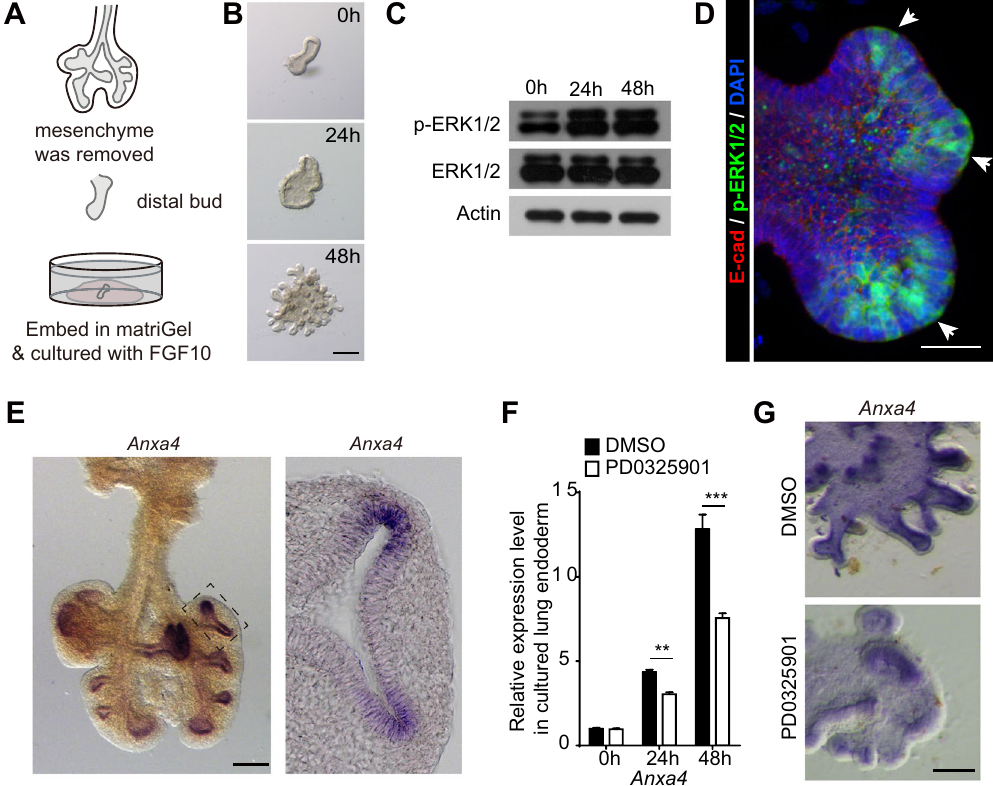
Figure 2. ERK1/2 signaling regulates the expression of Anxa4 . ( A ) Diagram illustrating the method for mesenchyme-free lung endoderm culture. Whole lung at E11.5 was digested with trypsin on ice and then the mesenchyme was removed using fine forceps to get intact lung endoderm. The distal lung endoderm buds were dissected out, embedded in Matrigel and cultured in serum-free medium containing recombinant FGF10. ( B ) Images of cultured lung endoderm taken at different time points. There is no obvious bud formation at 24 h after culture. By 48 h, the lung endoderm starts budding and forms many buds. Scale bar: 200 μ m. ( C ) Western blot of cultured lung endoderm explants at 0 h, 24 h and 48 h using antibodies against p-ERK1/2, total ERK1/2 and reference Actin. The phosphorylation level of ERK1/2 was increased significantly at both 24 h and 48 h. Full-length blots are presented in Supplementary Fig. s6. ( D ) Bud of cultured lung endoderm were analyzed by E-cadherin (red) and p-ERK1/2 (green) immunostaining. The bud tips (arrowhead) showed higher p-ERK1/2 staining compared to middle cells. Scale bar: 25 μ m. ( E ) Whole-mount and section in situ hybridization of Anxa4 in WT lungs at E12.5. Anxa4 was highly expressed in the bud tip epithelial cells adjacent to FGF10 expressing site. Scale bar: 200 μ m. ( F , G ) The expression level of Anxa4 in cultured lung endoderm explants at 0 h, 24 h and 48 h. The expression level of Anxa4 was increased significantly at both 24 h and 48 h as compared to 0 h and its expression level was inhibited by MEK inhibitor, PD0325901 ( F ). The whole mount in situ hybridization of Anxa4 confirmed that PD0325901 treatment could decrease the expression of Anxa4 ( G ). Data are presented as mean ± SEM, n = 3; ** p < 0.01; *** p < 0.001; Student’s t -test. Scale bar: 100 μ